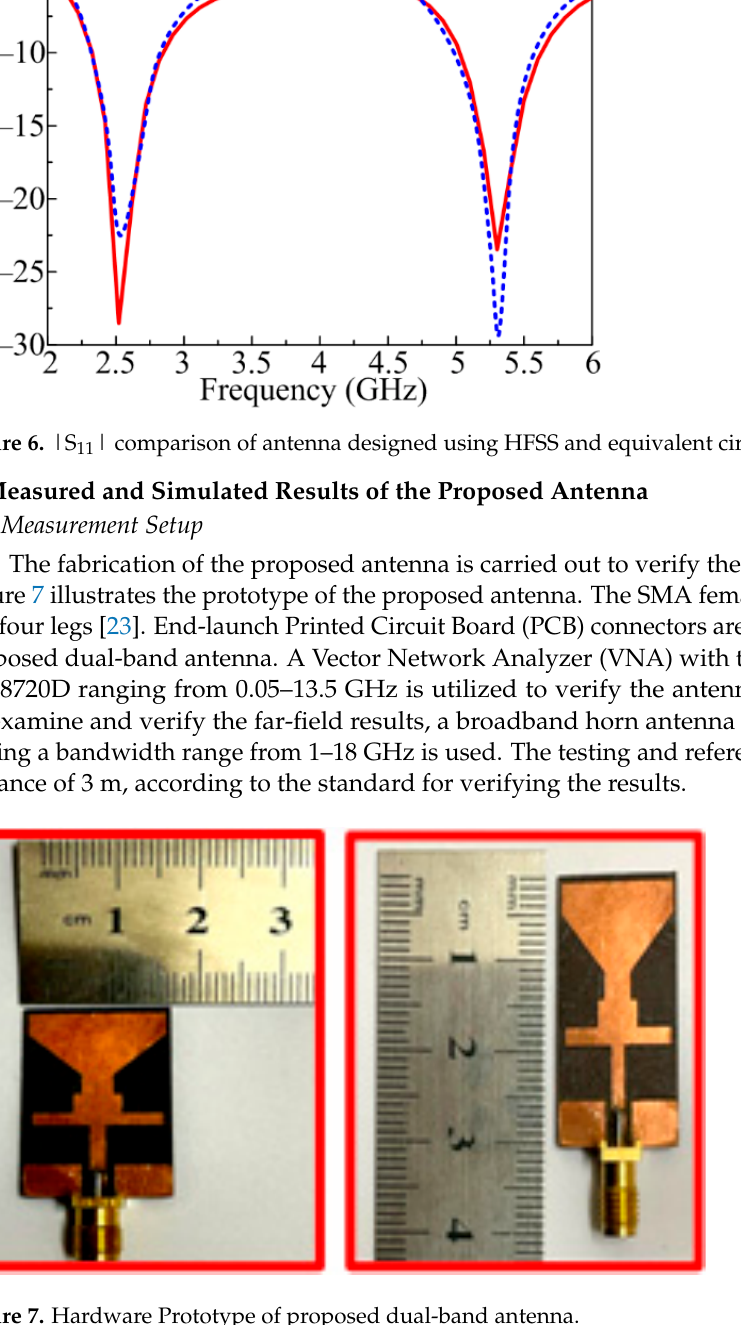
Figure 7. Hardware Prototype of proposed dual-band antenna.